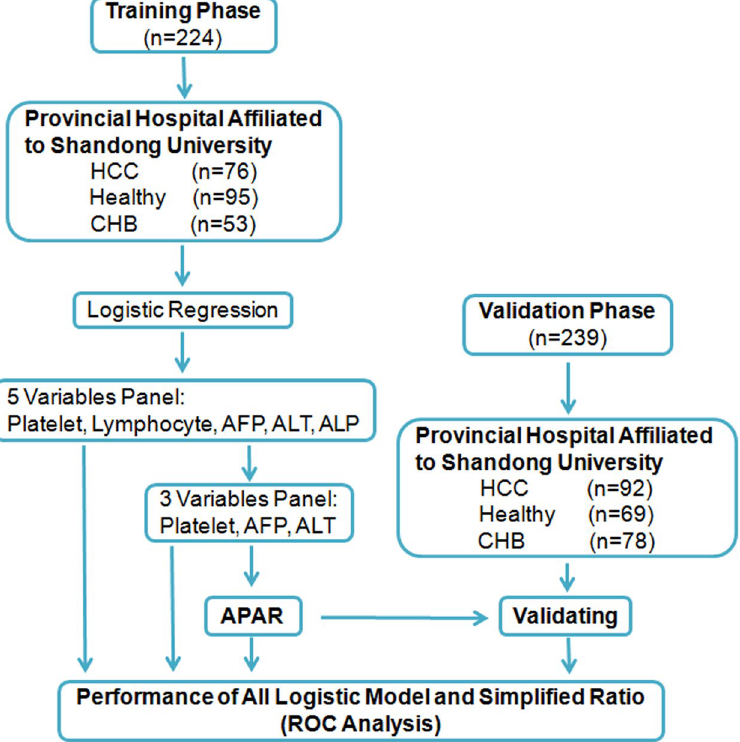
Figure 1. Study design. ALP, alkaline phosphatase; ROC, receiver operating characteristics; APAR: 1000 ×